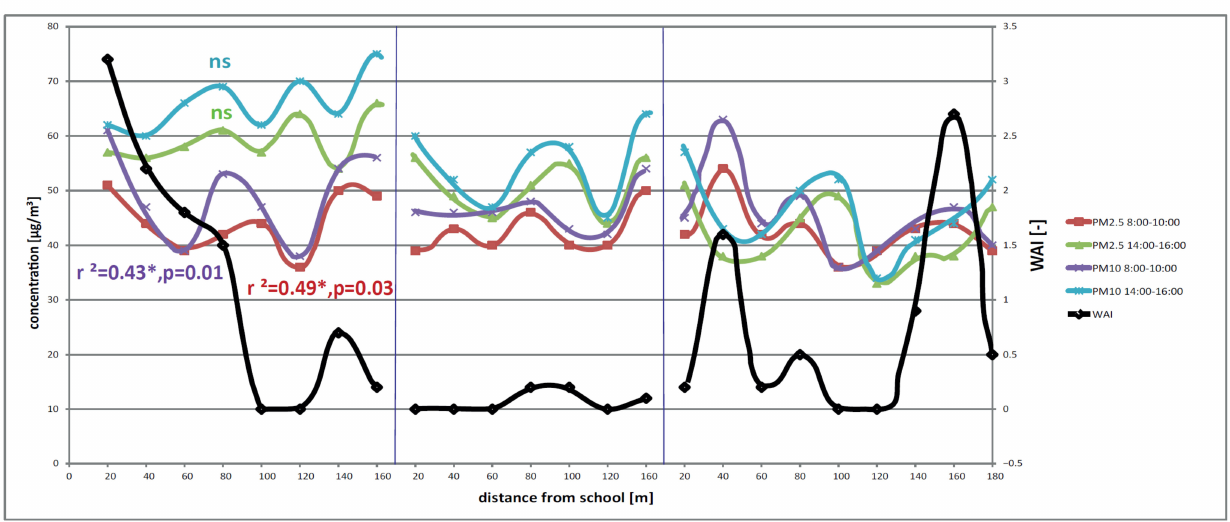
Figure 4. WAI distribution and an average PM concentration from 8:00 to 10:00 and from 14:00 to 16:00 in study plots along walking paths to school A (low share of trees, low number of local heating emission sources). ns—no significance.